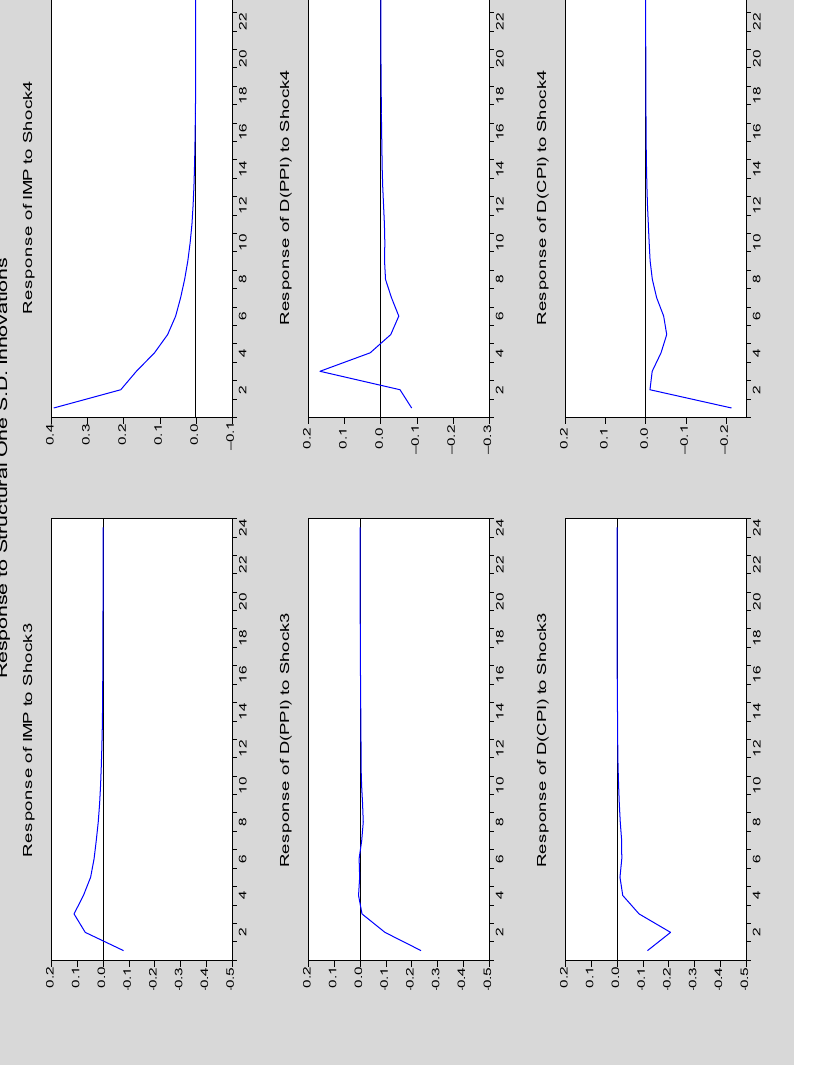
Figure 5. Impulse responses for IMP, PPI and CPI; extended